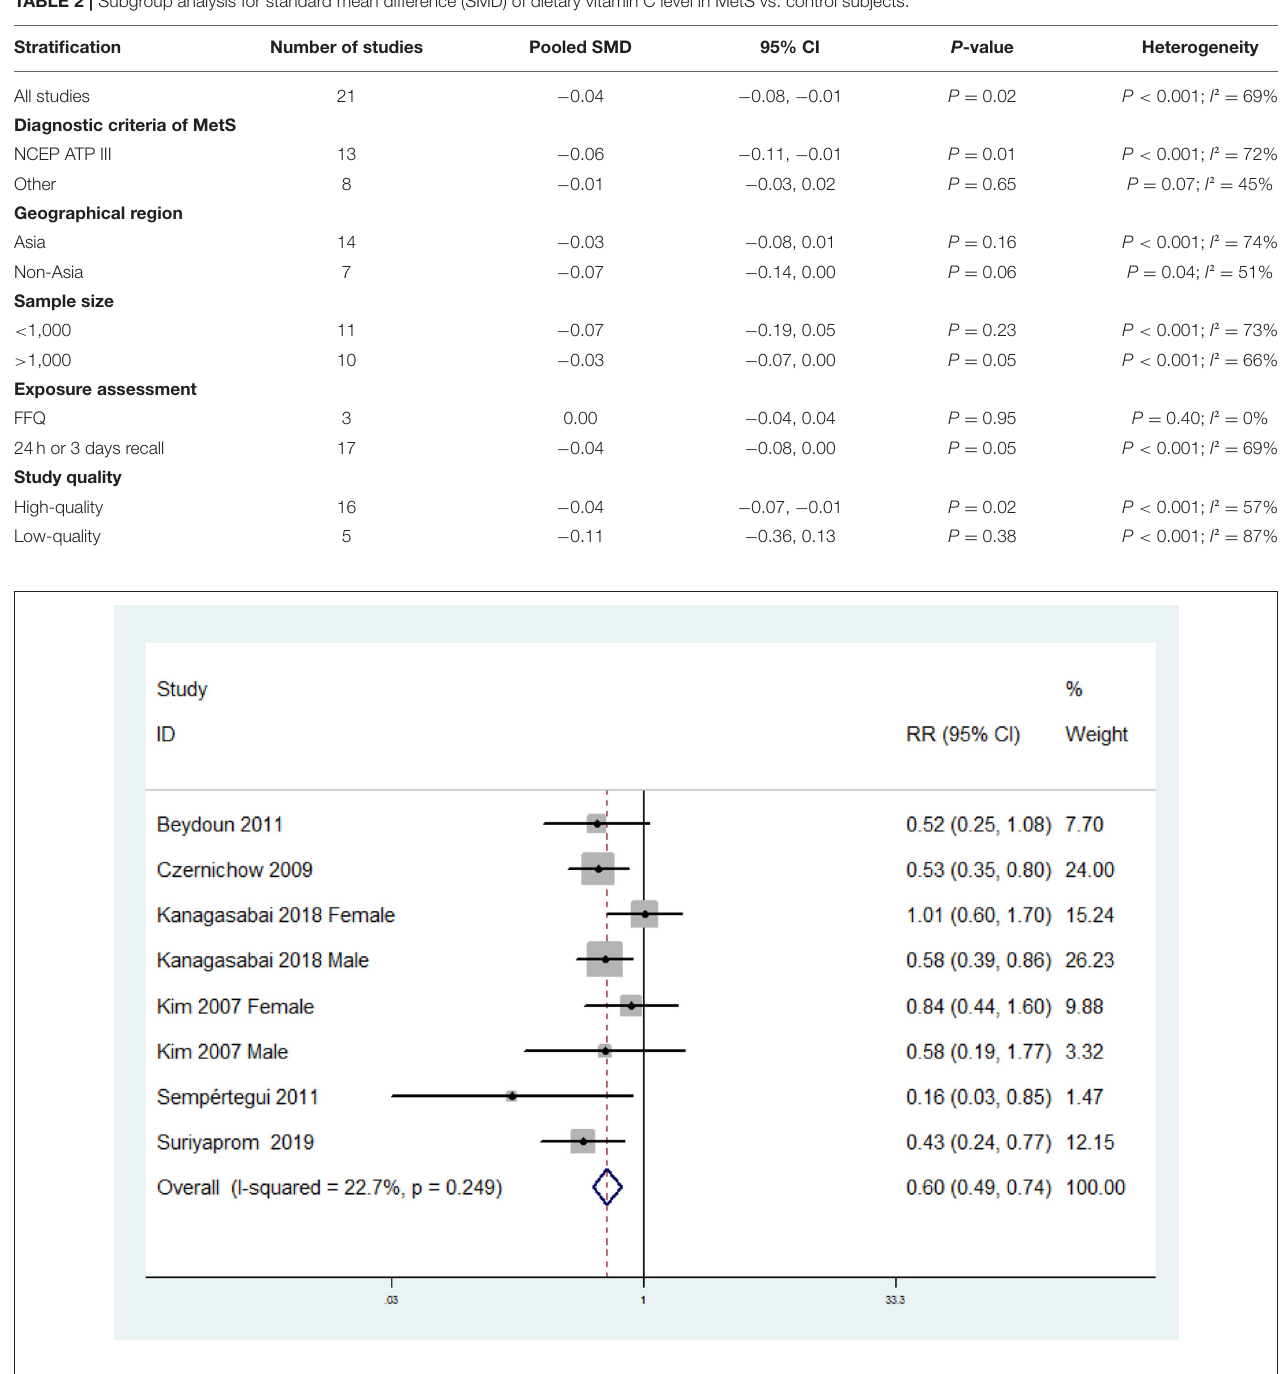
FIGURE 4 | Forest plot of meta-analysis. Overall multi-variable adjusted RR of MetS for the highest vs. lowest category of circulating vitamin C level.